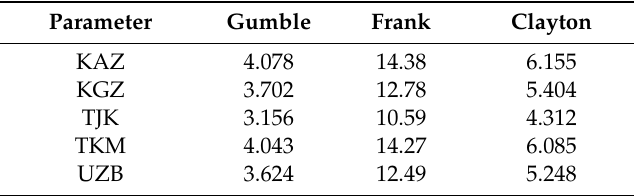
Table 6. The selection of 3D Copula